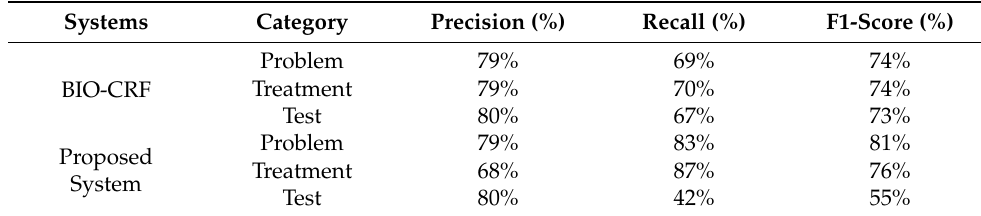
Table 7. Individual concepts’ performance measurements: proposed system vs. BIO-CRF